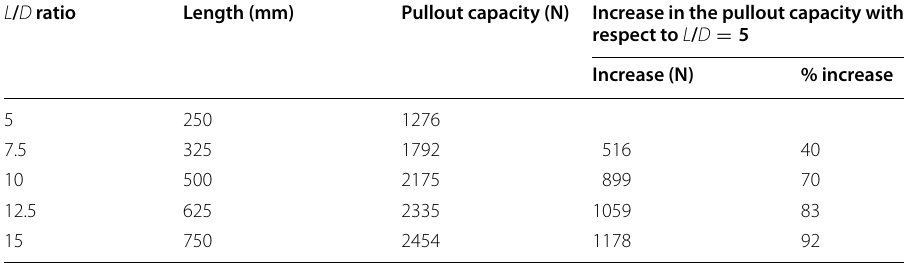
Table 3 Effect of the L / D ratio on the pullout capacity of a 50 mm diameter single GPA L / D ratio Length (mm) Pullout capacity (N) Increase in the pullout capacity with